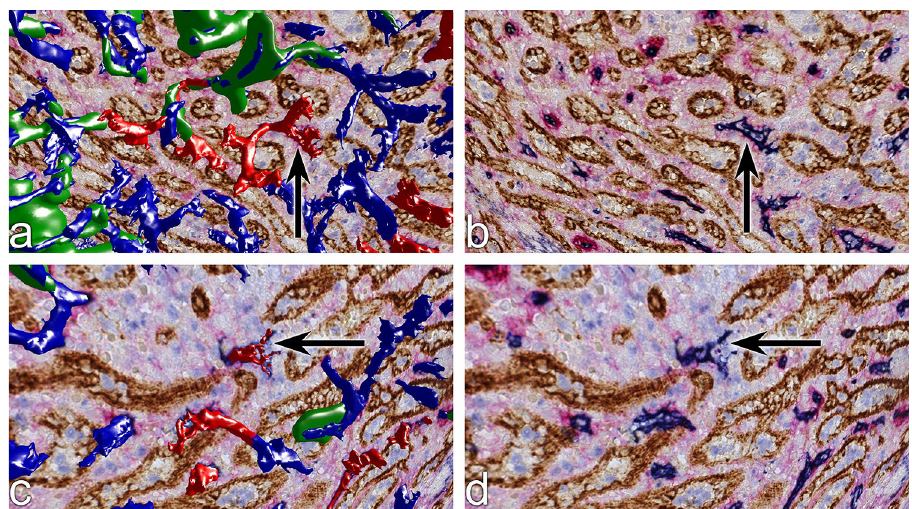
Figure 6. Correlation of capillary end 3D models shown in Fig. 5c,f with single registered sections through the ends. ( a,b ) Section with and without model of capillary end (arrow) indicated in Fig. 5c. ( c,d ) Section with and without model of capillary end (arrow) indicated in Fig. 5f. The entire sequence of sections through the open ends is seen in Supplementary videos S3,